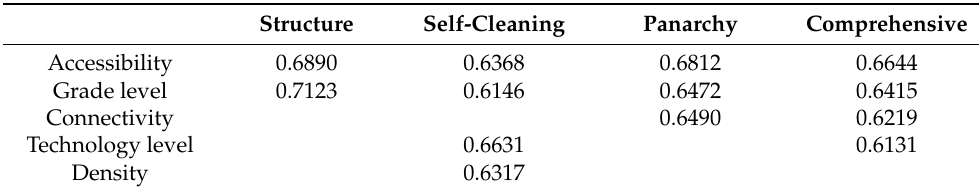
Table 10. Interactive relationship between agricultural production, road construction and the agricul- tural